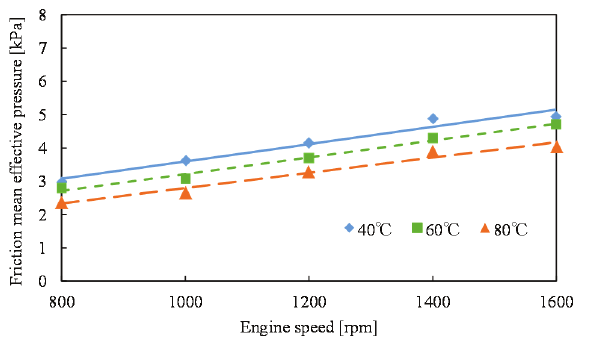
Fig. 8. FMEP with two-ring set without second ring